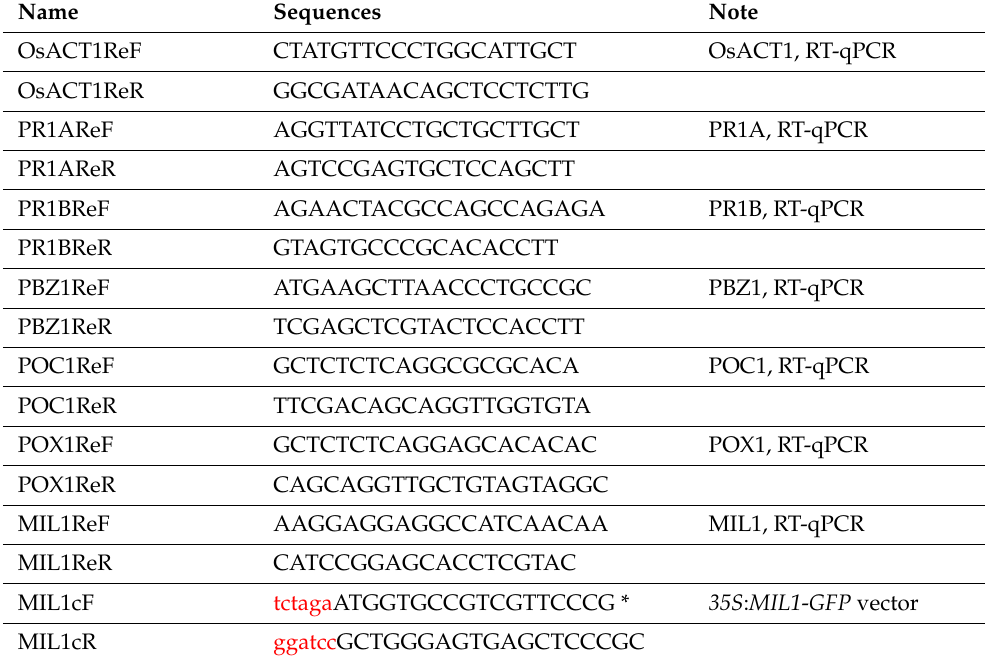
Table 2. Primers used in the